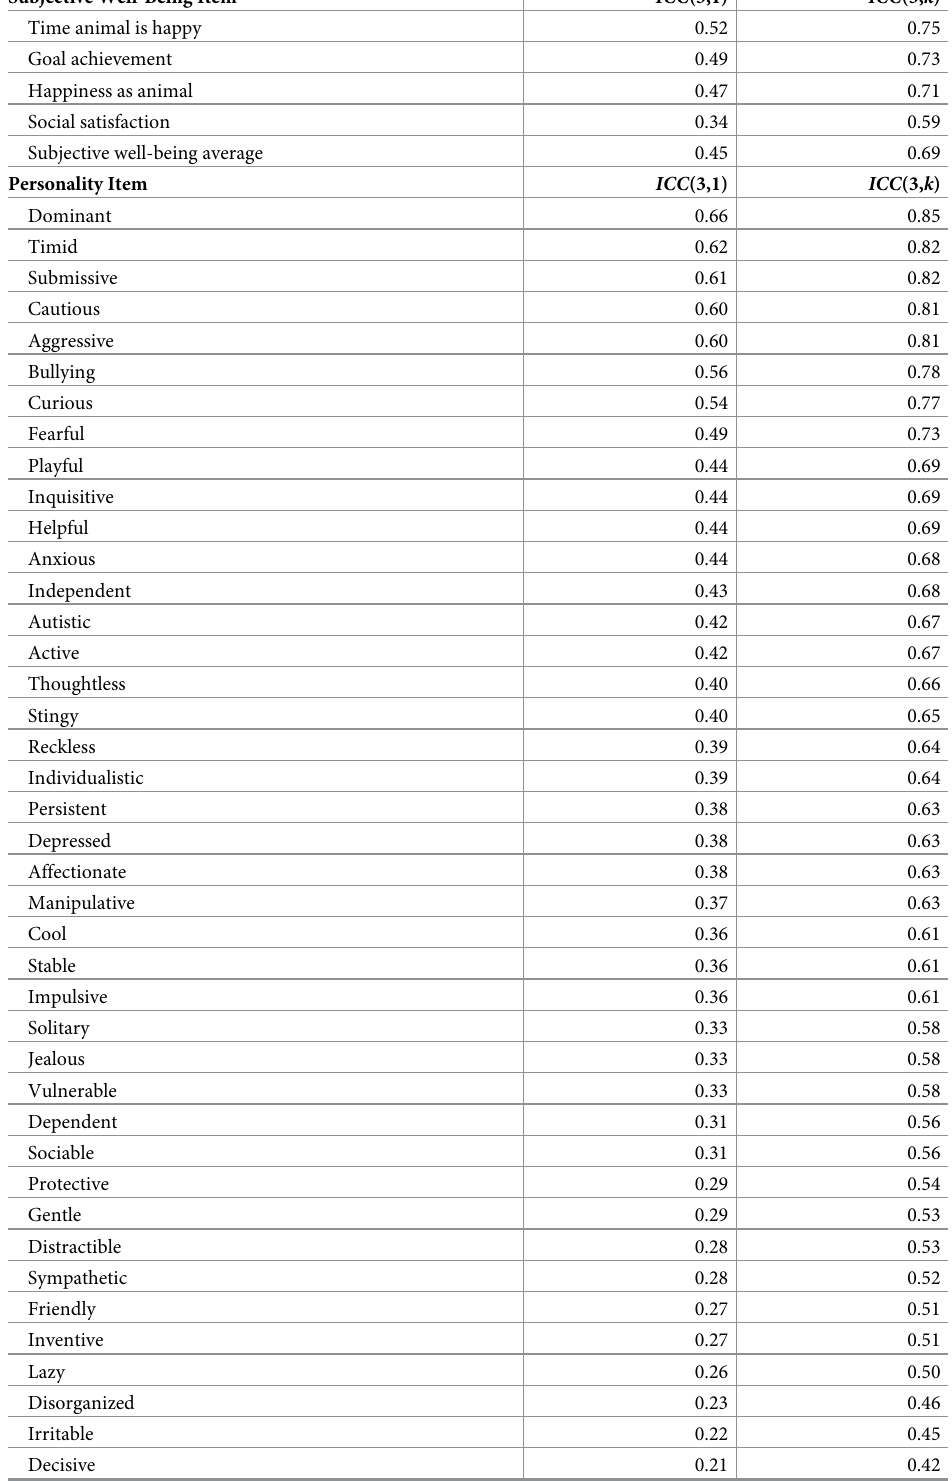
Table 1. Interrater reliability of subjective well-being and hominoid personality questionnaire